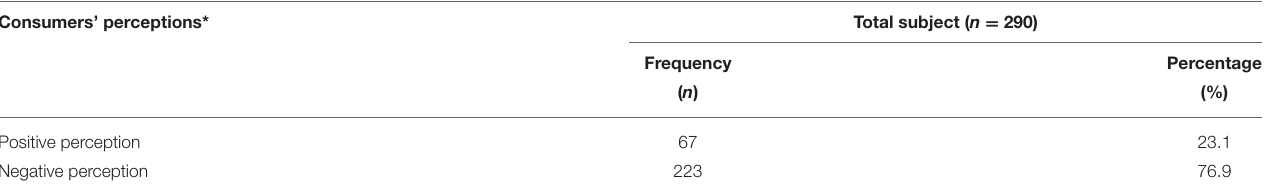
TABLE 5 | Consumers’ perceptions on healthy food availability in OFD apps.